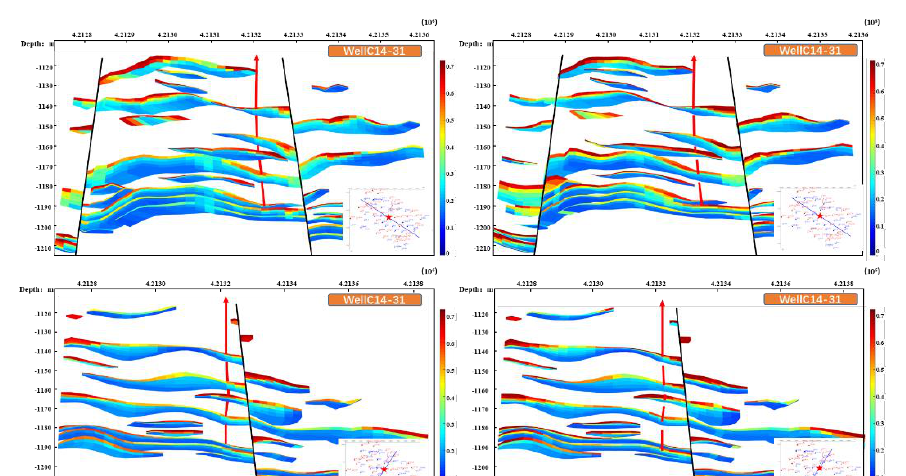
Figure 12. Cross section of remaining oil saturation of well C14-31 (the upper left one and the lower left one are the remaining oil profiles calculated by the numerical simulation method considering anisotropic relative permeability, and the upper right one and lower right one are the results of a traditional simulation).